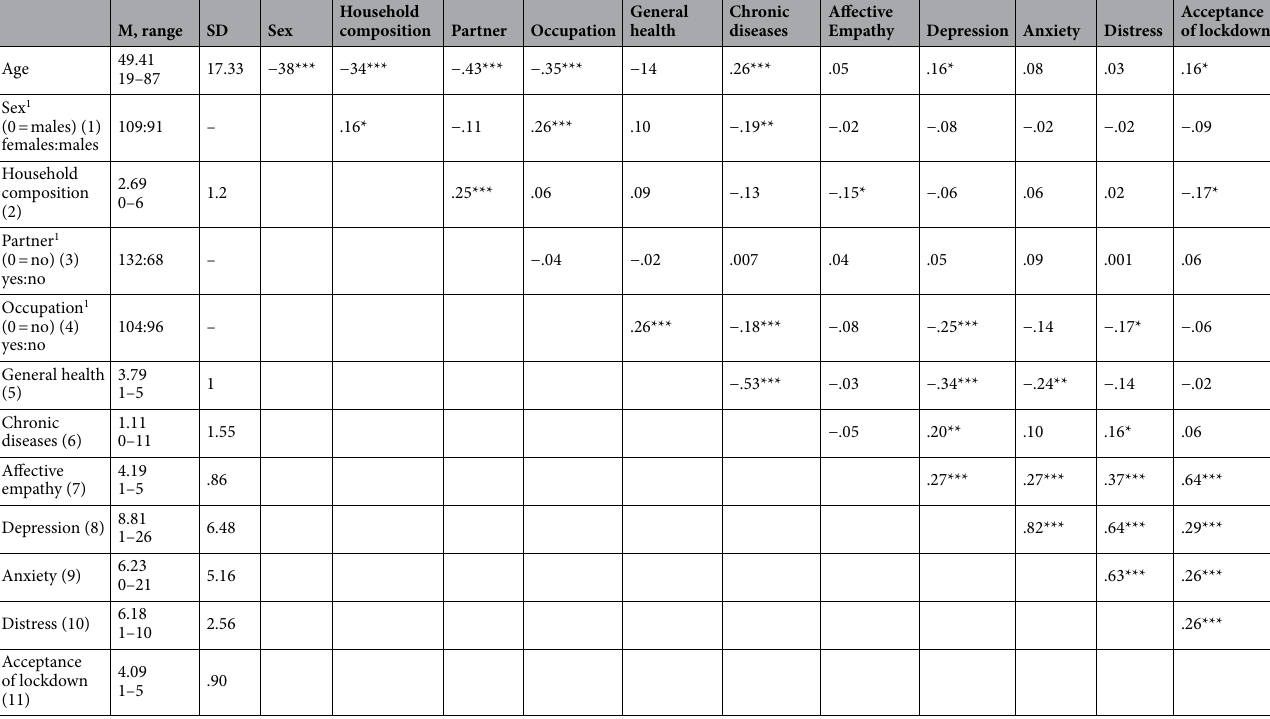
Table 4. Correlations, Phase 2. * p < .05. ** p < .01, *** p < .001. 1 = point biserial correlations were